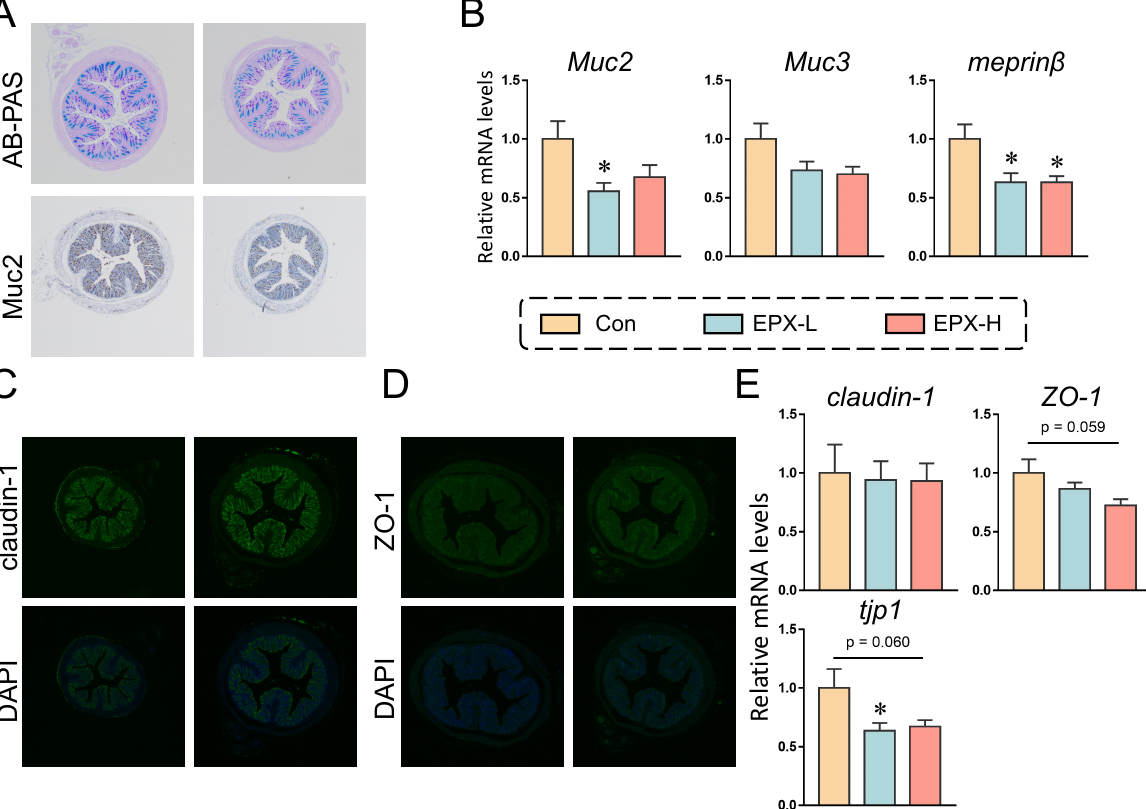
Figure 2. Effects of the oral exposure to EPX on the intestinal barrier function of mice. ( A ) AB-PAS staining and immunohistochemistry of Muc2 in the colon ( n = 3). ( B ) The transcriptional levels of genes related to mucous secretion: Muc2 , Muc3 , and meprin β . ( C , D ) Immunofluorescent staining of claudin-1 and ZO-1 ( n = 3). ( E ) The transcriptional levels of genes related to tight junction: claudin-1 , ZO-1 , and tjp1 . Values are shown as the means ± SEM ( n = 8), and statistical significance: p < 0.05